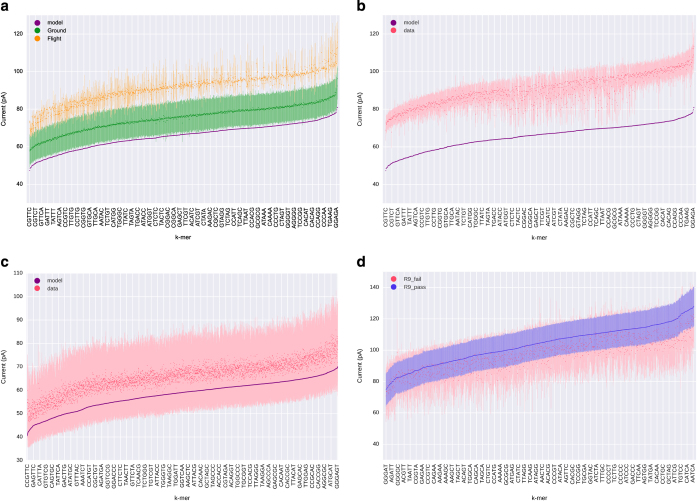
(a) Current distributions by 5-mer for flight data, ground data, with k-mers ordered by expected means stored in Metrichor's Hidden Markov Model. S.d. of the mean were calculated across reads for the flight and ground data. (b, c) The maximum deviations from the models we observed among seven runs with kit version SQK-MAP-005, and five runs with the SQK-MAP-006 kit, moving to a 6-mer model. (d) Current distributions for a run with the newest (R9) version of the nanopore. For this version, Metrichor does not provide a model, using a recurrent neural network to base call reads, therefore we compared ‘pass’ (average quality>9) and ‘fail’ reads, ordering k-mers by their mean across pass reads.